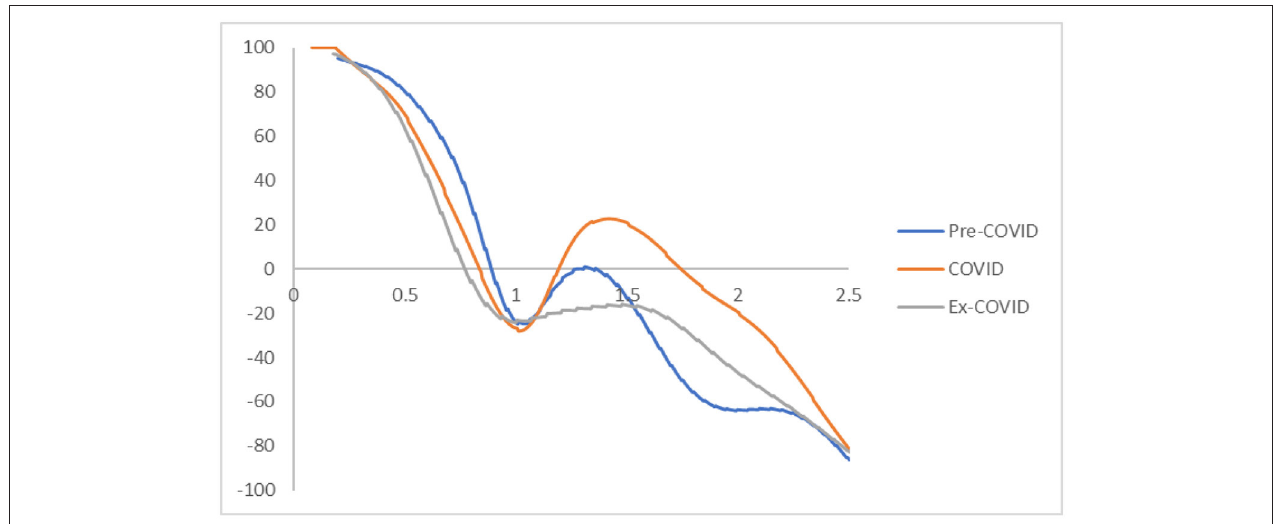
FIGURE 2 | Mobility probability plot (MPP) for the RDIPC of all residents in cities with the longest duration of Level I ERS with quarterly transitions. Source: authors’ calculation. N.B. The vertical axis indicates net upward mobility (%) and the horizontal axis indicates RDIPC values.